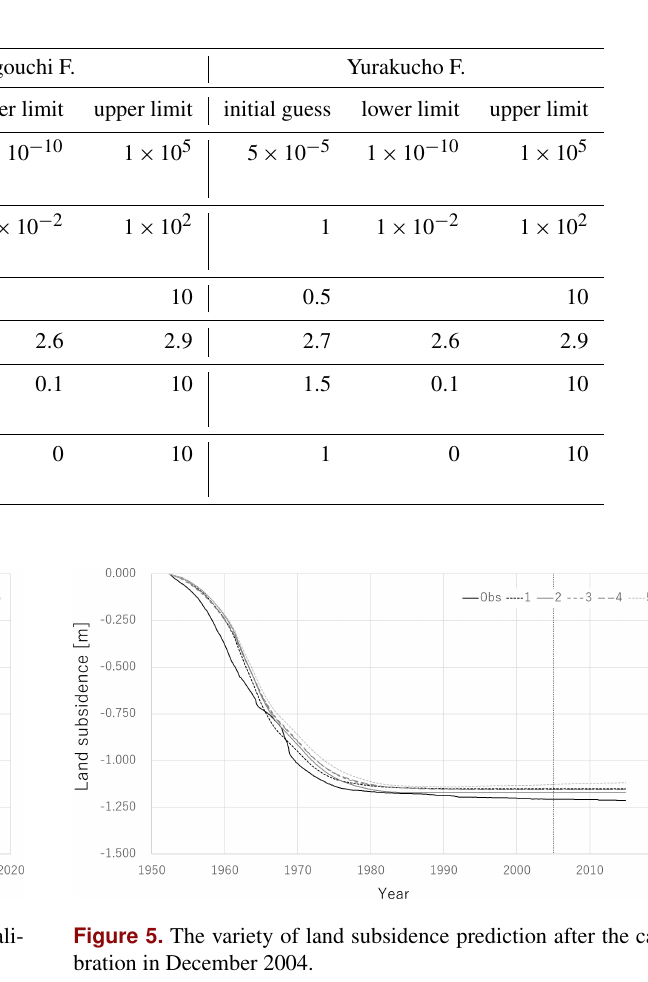
Table 1. Parameter space for a test.